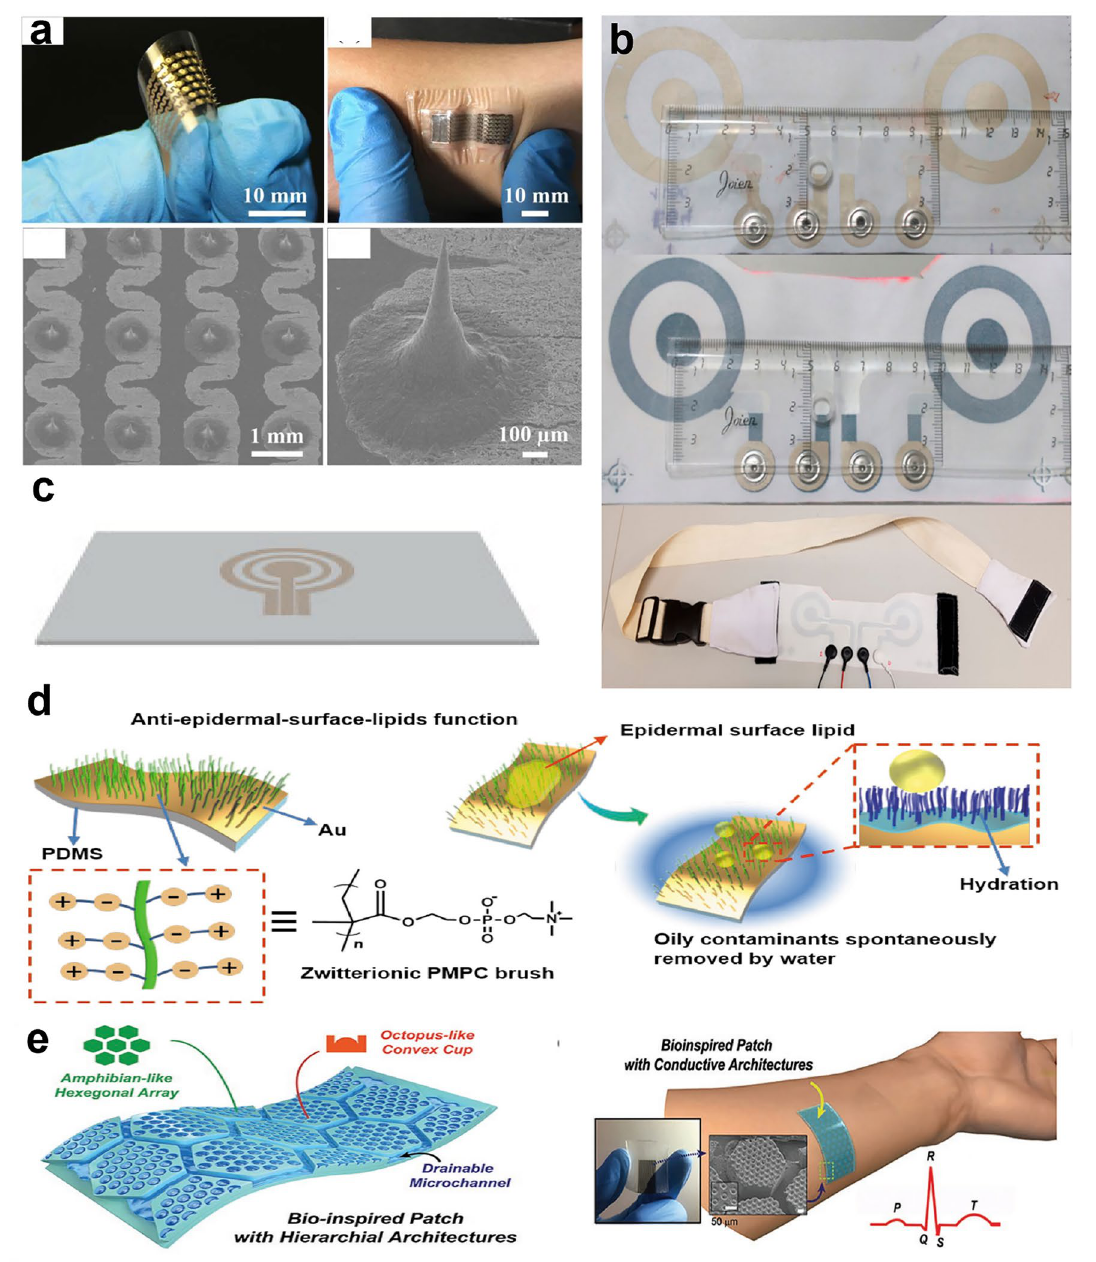
Fig. 14 Typical electrodes with conductive patterns. a Image of the soft MAE. Reproduced with permission [298]. Copyright (2018), MDPI. b Schematic diagram of concentric ring electrodes (CREs) and CRE integrated with an adjustable belt. Reproduced with permission [299]. Copy- right (2018), MDPI. c AgNWs paste screen printed on a glass substrate with a shape of the tripolar concentric ring. Reproduced with permission [308]. Copyright (2019), Institute of Electrical and Electronics Engineers. d Configuration of the designed electrode (left) and the water-enabled oil-cleaning effect (right). Reproduced with permission [304]. Copyright (2020), Wiley–VCH. e A skin patch inspired by the microchannel network of the tree frog toe pad and the convex cup on the octopus’s sucker. Reproduced with permission [307]. Copyright (2020),